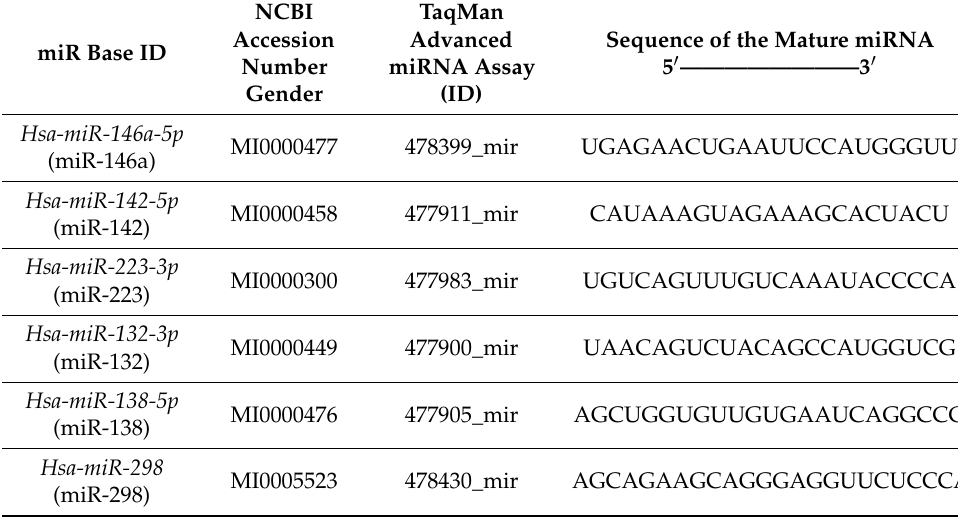
Table 3. Indication of the sequences of the candidate microRNAs and the endogenous normalizer microRNA